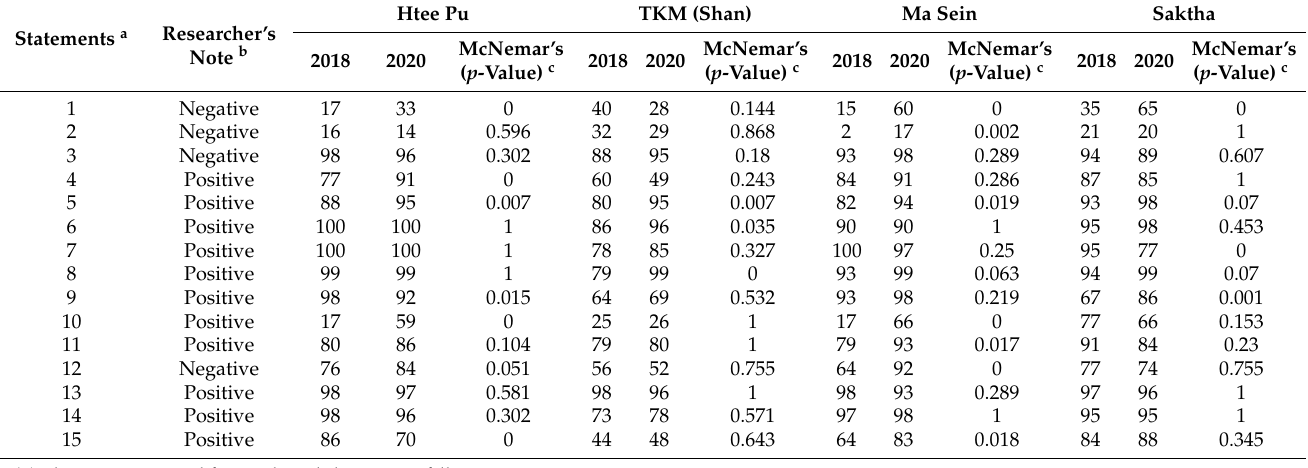
Table 6. Proportion of respondents who agree on the knowledge statements related to household nutrition in four